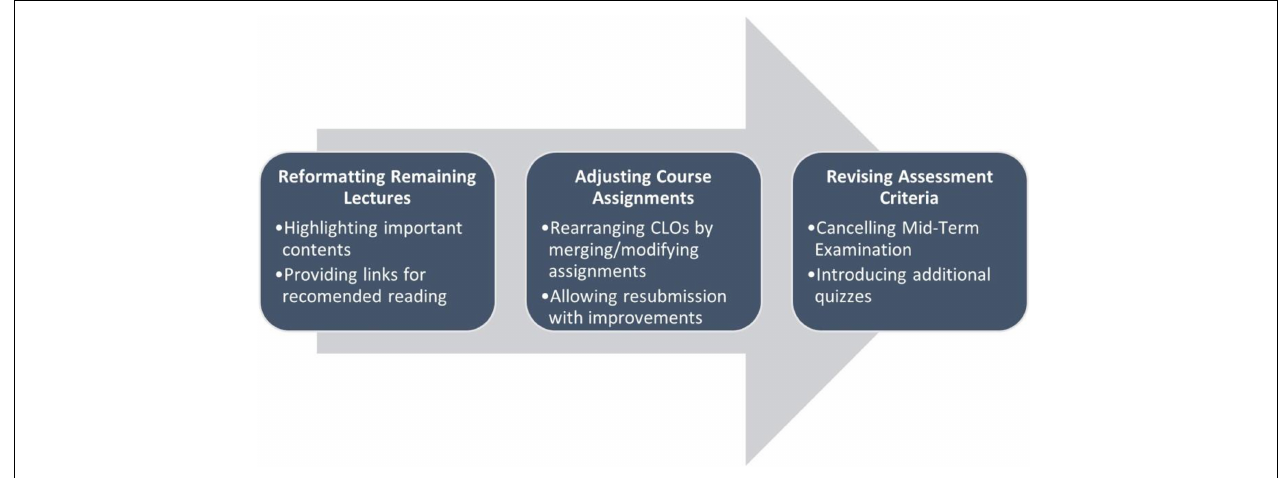
FIGURE 1 | Steps involved before resuming online classes.